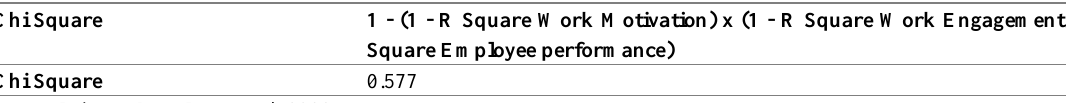
Table 4: Goodness of Model Test (Chi-Square Value) Chi